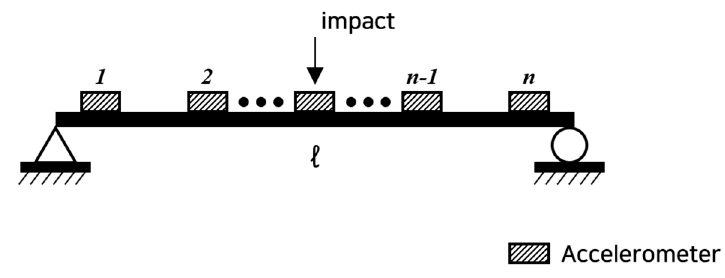
Figure 1. Layout of the impact hammer and accelerometers.